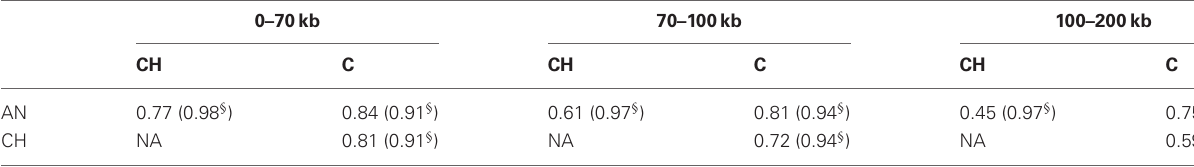
Table 5 | Correlation of LD phase among breed groups.